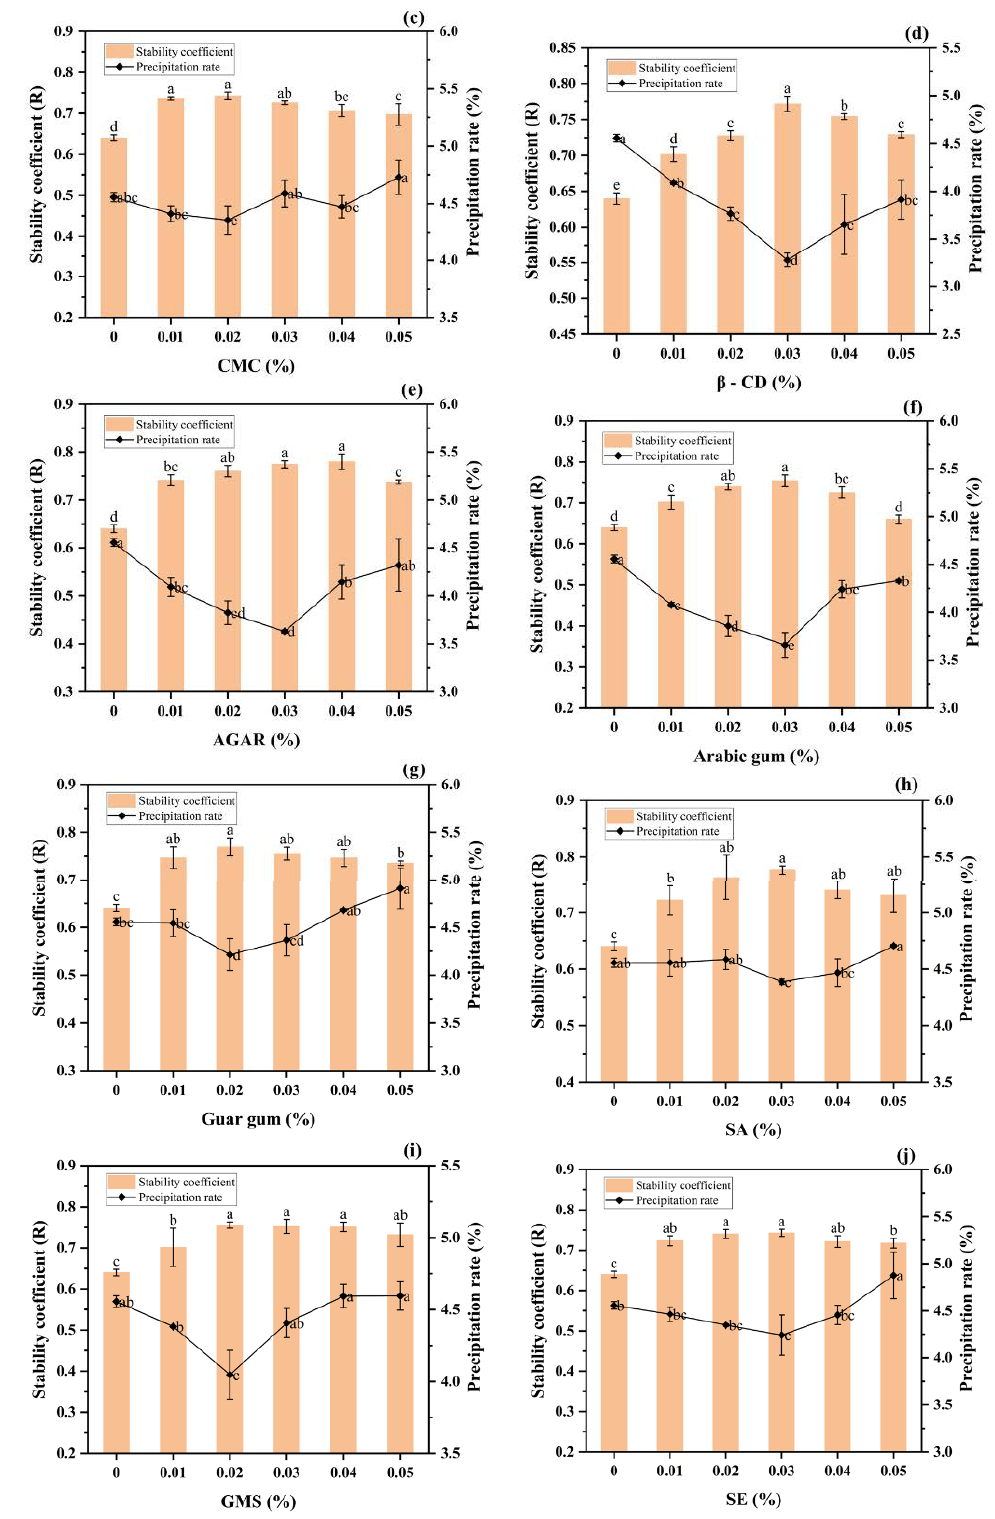
Figure 1. Single-factor test of different stabilizers (data represent mean ± SD, and the different letters on the columns indicate a significant difference at p < 0.05). ( a ) Xanthan gum; ( b ) Carrageenan; ( c ) Sodium carboxymethyl cellulose (CMC); ( d ) β -cyclodextrin ( β -CD); ( e ) AGAR; ( f ) Acacia gum; ( g ) Guar gum; ( h ) Sodium alginate (SA); ( i ) Glycerol monostearate (GMS); ( j ) Sucrose esters (SE).